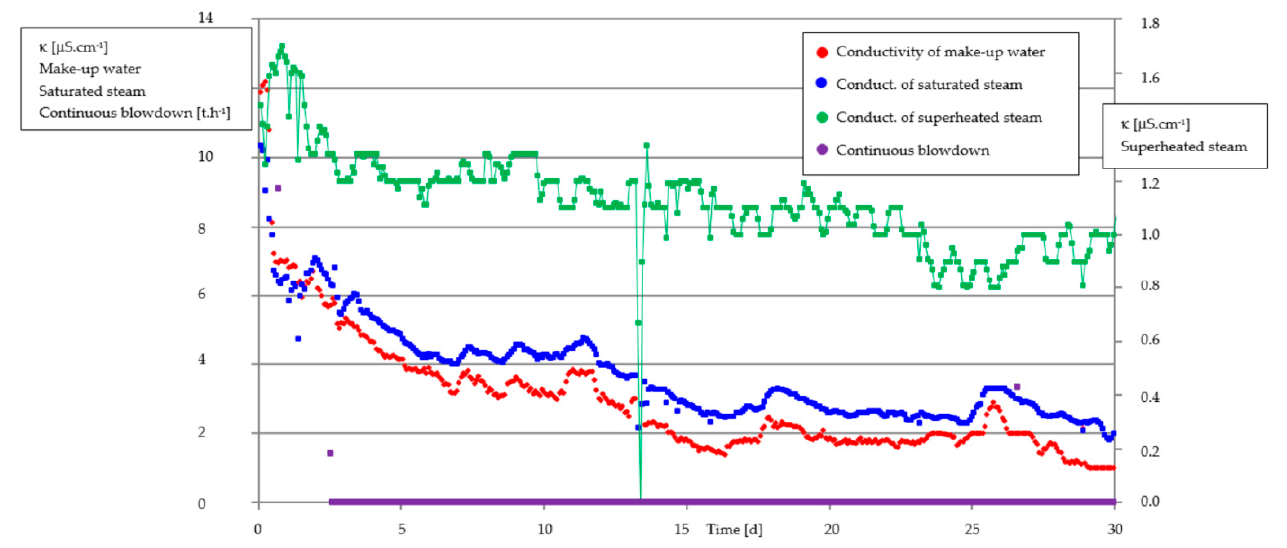
Figure 8. The recycling of turbine condensate by EDI with continual blowdown (violet line, covering x axis) closed 3 days after applying EDI.